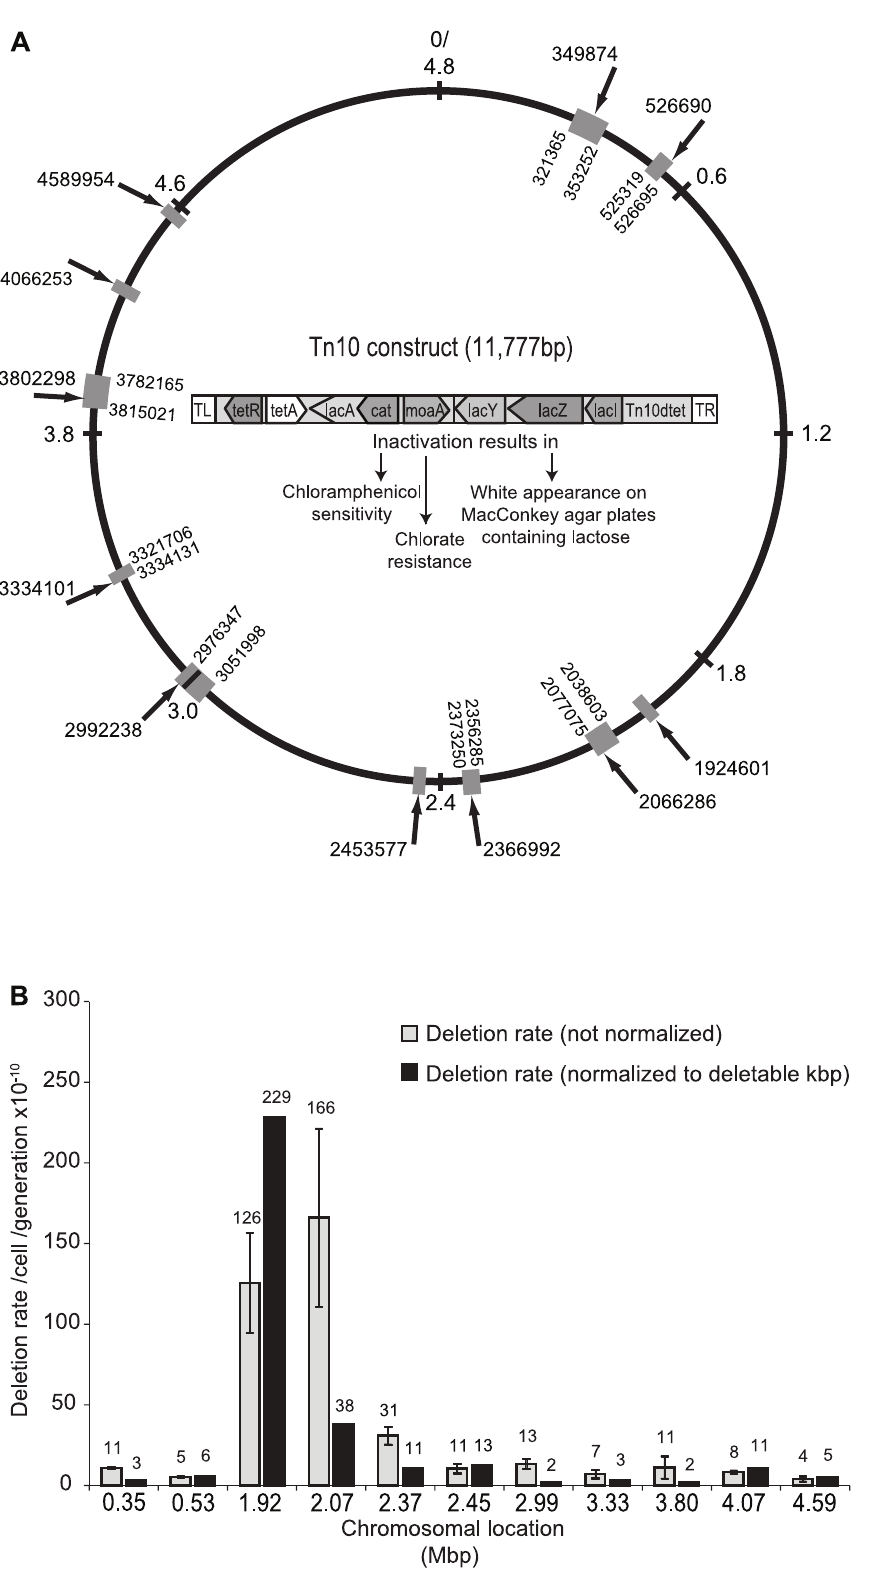
Figure 1. Chromosomal locations of the Tn 10 construct and deletion rates. ( A ) Schematic representation of the Salmonella typhimurium LT chromosome and the structure and insertion points of the Tn 10 construct used for measurements of deletion rates. Numbers and arrows outside the chromosome ring indicate the Tn 10 insertion point. The relative size of the grey box and the numbers on the inside of the ring indicate the size of the deletions isolated in that specific region. When numbers are absent this indicate that the deletions were internal to the Tn 10 construct. In the middle,